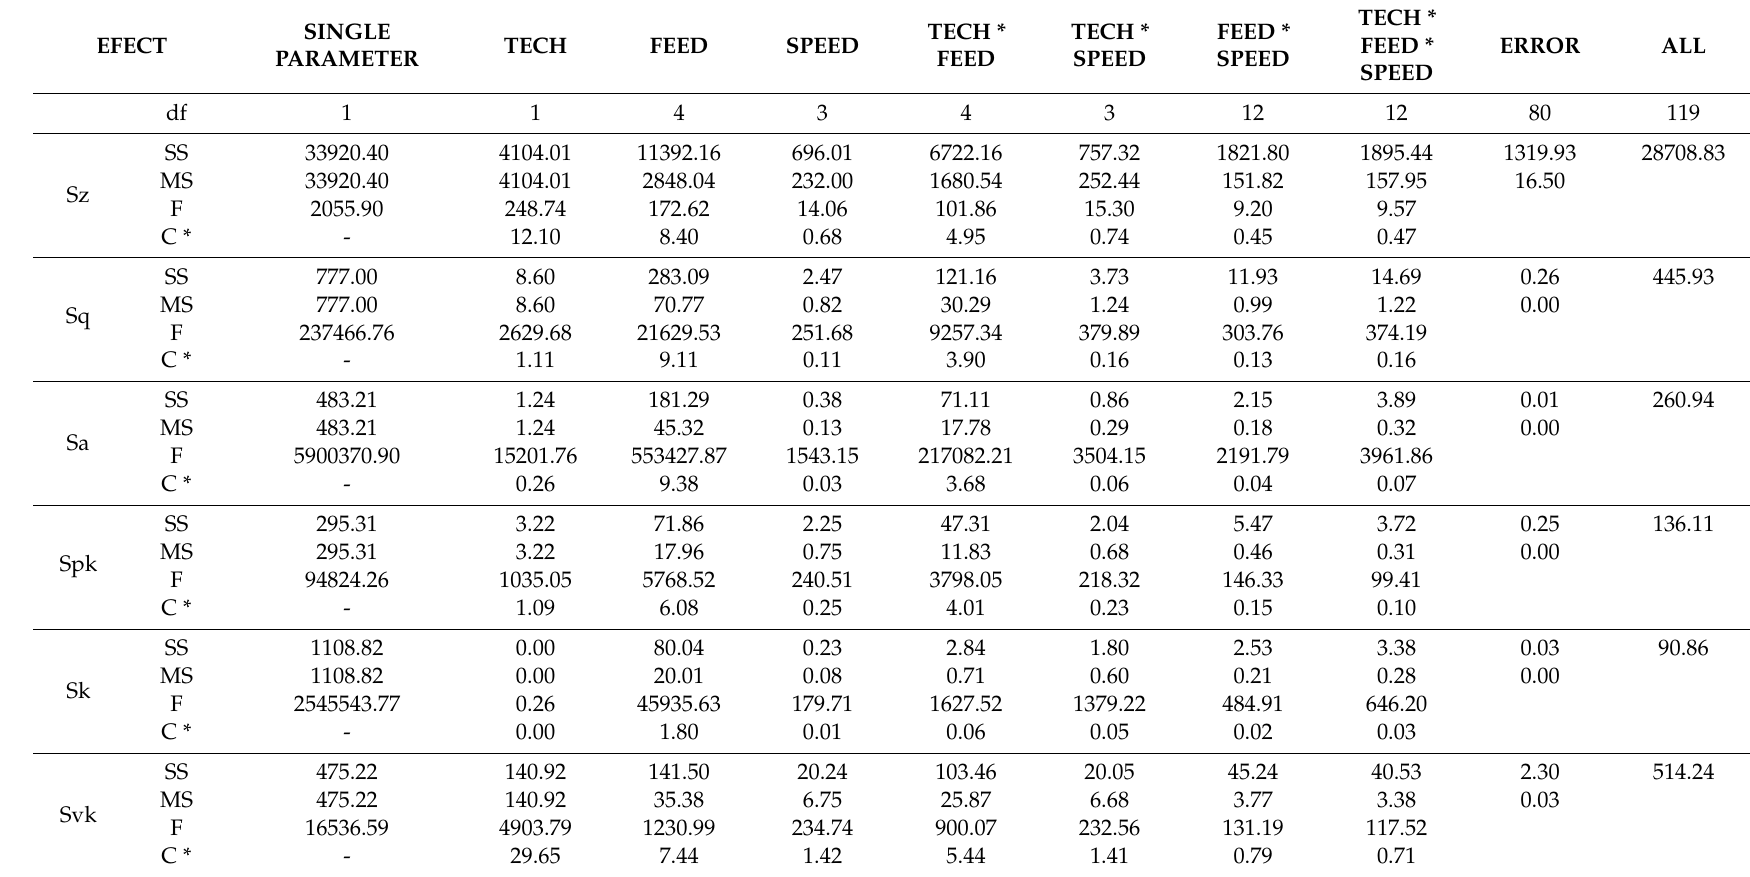
Table 5. Detailed results of analysis of variance